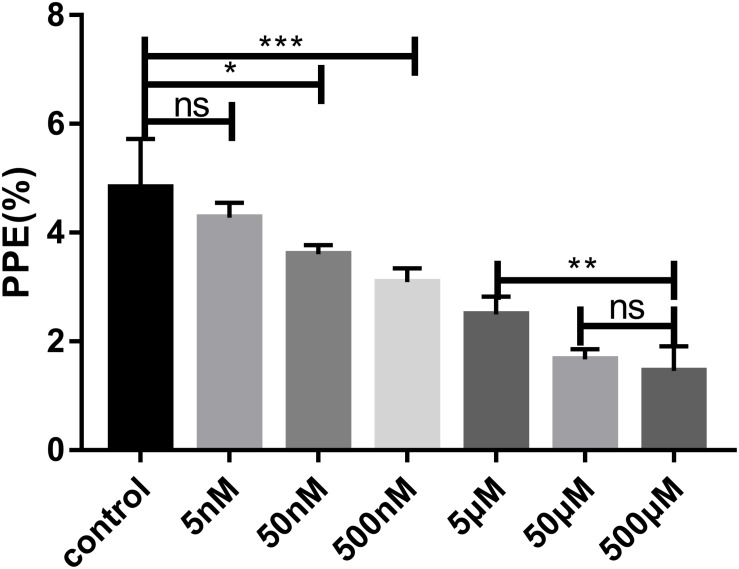
Parasitemia of different drug concentrations after 72 h of treatment. Evaluation of the susceptibility of B. microti in vitro to fosmidomycin at concentrations from 5 to 500 μM. Giemsa staining assay at 72 h after the addition of the drug. PPE, pollen productivity estimate; Ns, not significant (P > 0.05); *P < 0.05, **P < 0.01, ***P < 0.001.